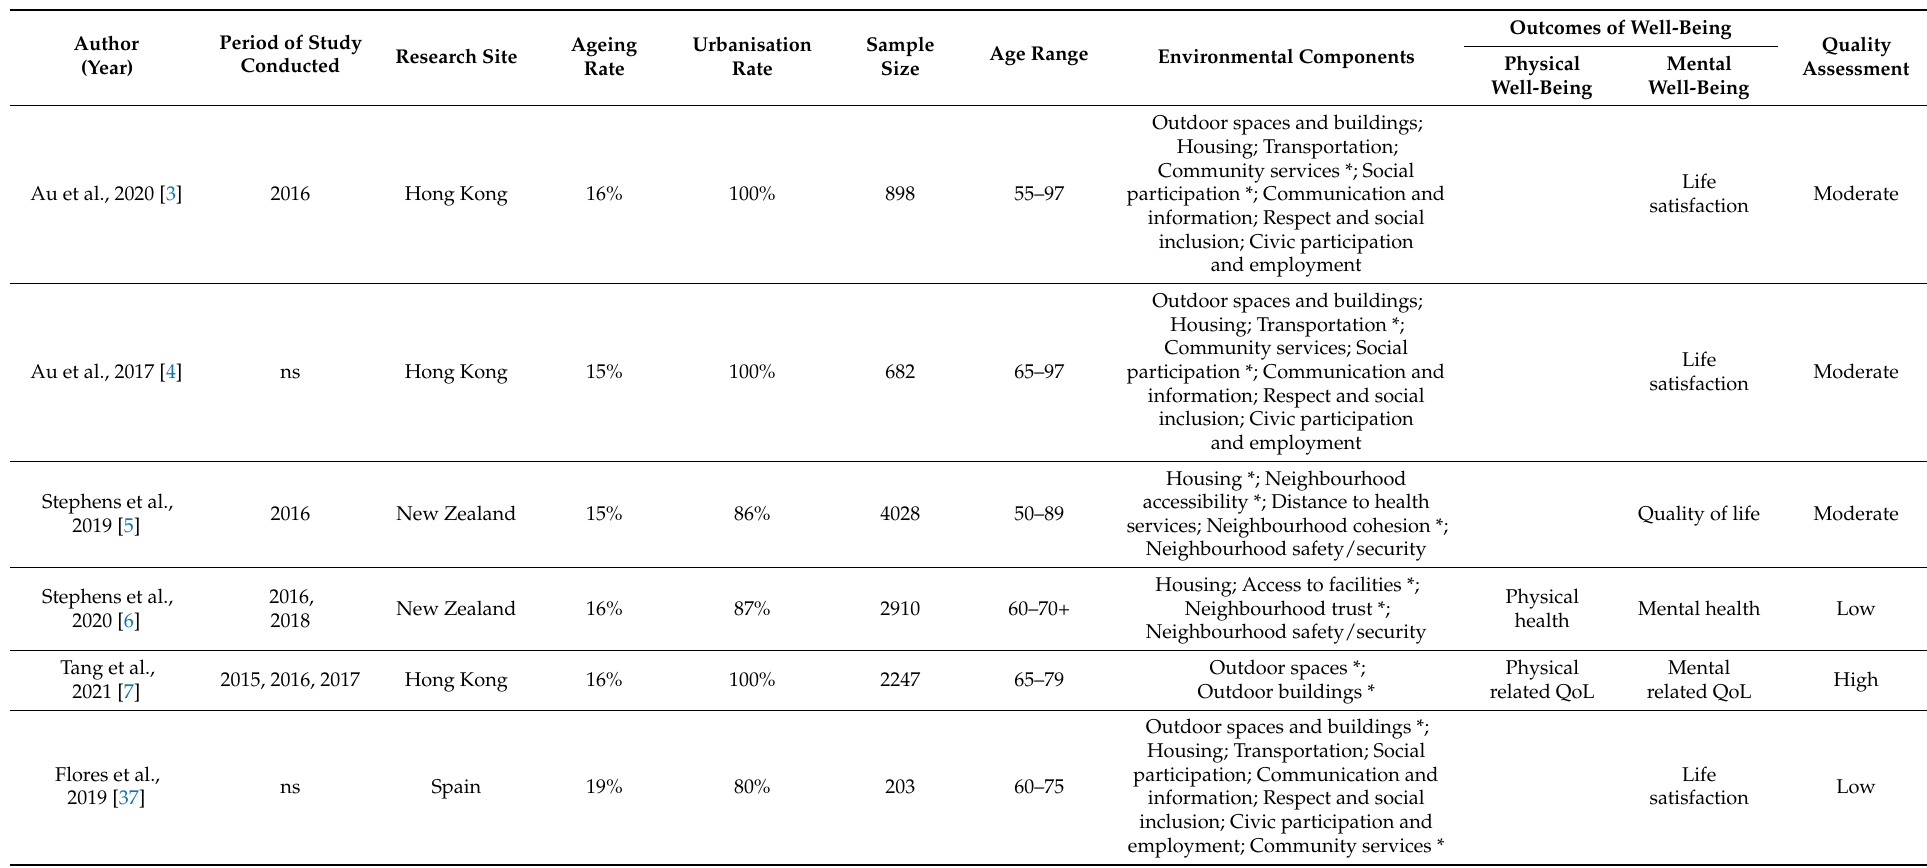
Table 1. Summary of information of selected